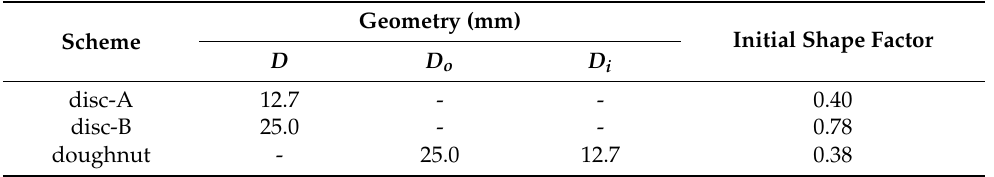
Figure 3. Geometries of the rubber specimen: ( a ) disc, and ( b ) doughnut (dimension in mm). Table 1. Dimensions of the rubber specimen.